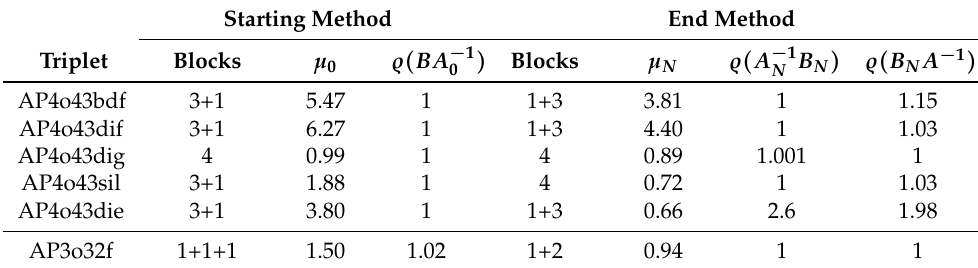
Table 2. Properties of the boundary methods of Peer triplets.